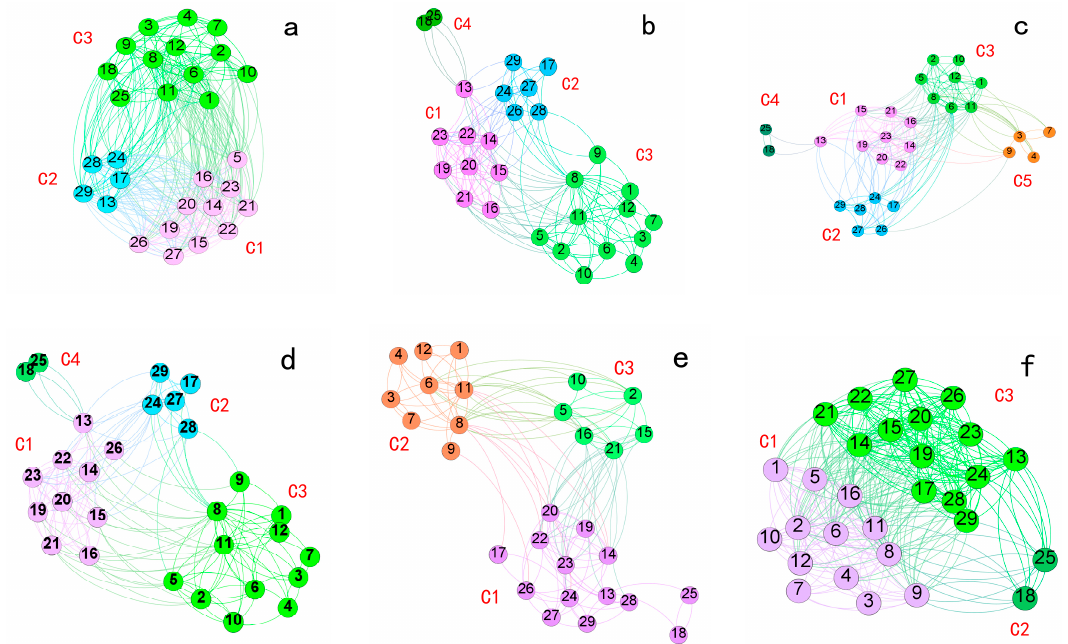
Figure 12. Topology views with the independent layout method: ( a ) layer1, ( b ) layer2, ( c ) layer3, ( d ) the overlap layer of layer1 and layer2, ( e ) the overlap layer of layer1, layer2, and layer3, and ( f ) the aggregation layer.